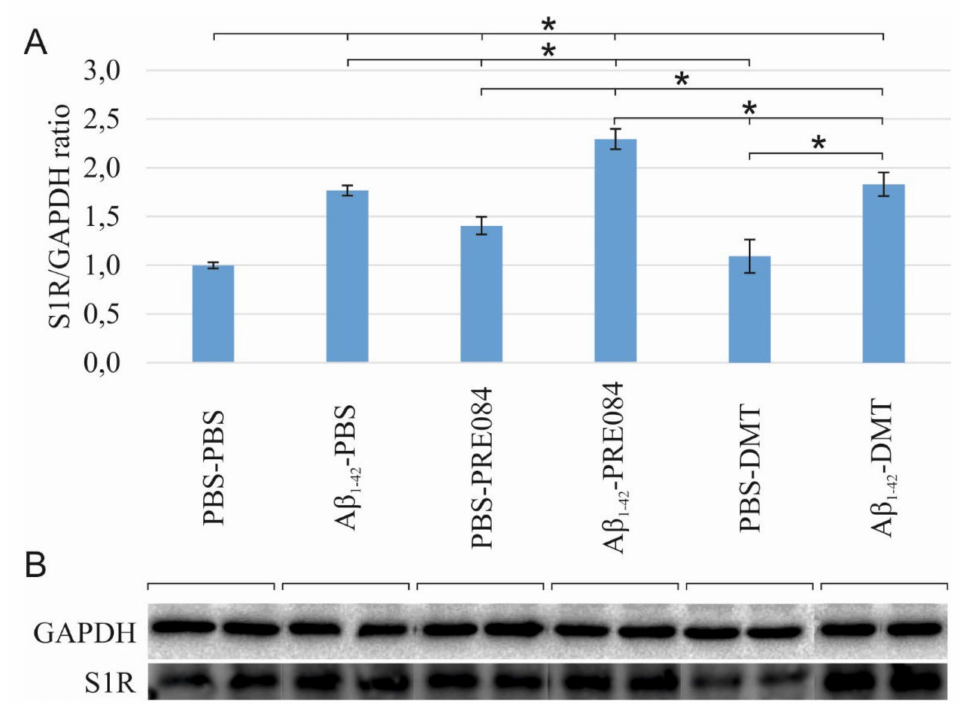
Figure 6. ( A ) Results for the western blot (WB) analysis. Significant differences were observed in the S1R levels among the groups (ANOVA: p ≤ 0.0001). Compared to PBS-PBS-treated mice, the